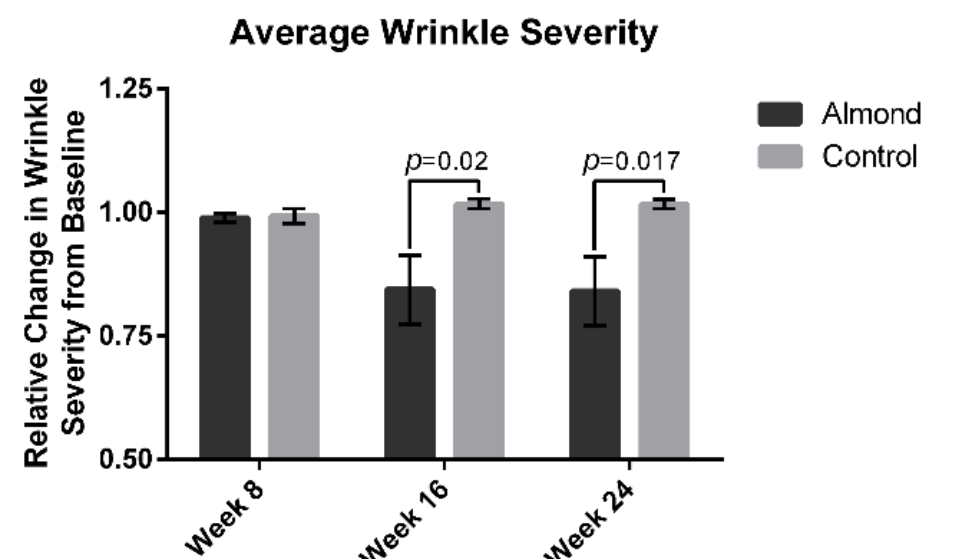
Figure 3. Computer-based photographic analysis of wrinkle severity was significantly decreased in the almond intervention group compared with the control intervention by 15% and 16% at week 16 and 24, respectively. Significant p values are noted on the figure. Error bars represent the standard error of the mean (SEM).